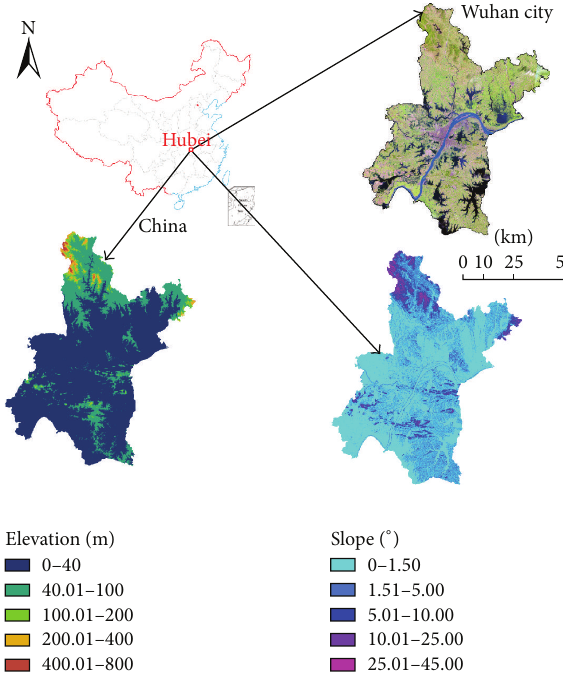
Figure 1: Location of the study area.